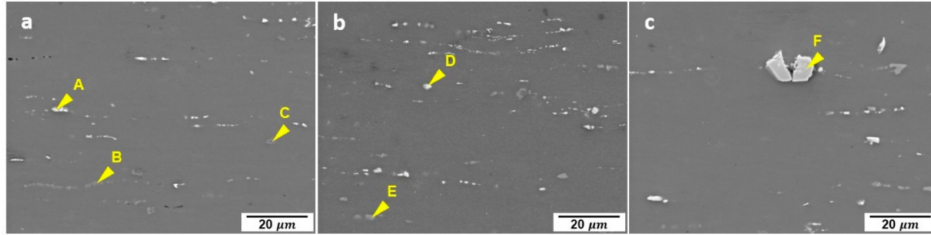
Figure 5. Secondary electron micrographs of the annealed ( a ) AZXW1000, ( b ) AZXW2000, and ( c ) AZXW3000 alloy sheets, respectively. The energy-dispersive X-ray spectroscopy results on the second phases marked by arrows A to G are given in Table